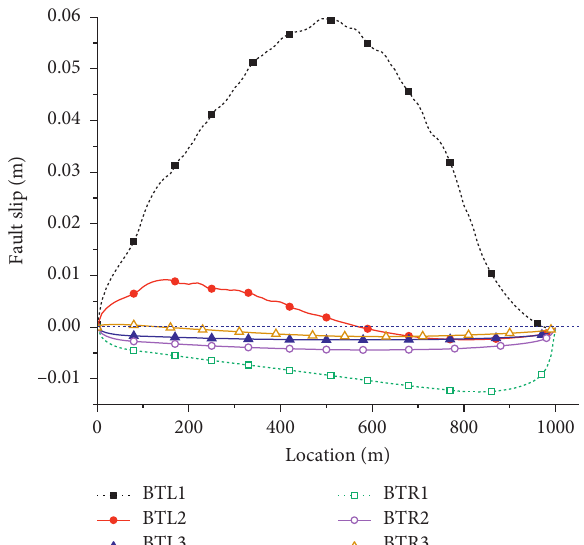
Figure 21: Fault slip along the fault plane when region BTchanged in the horizontal